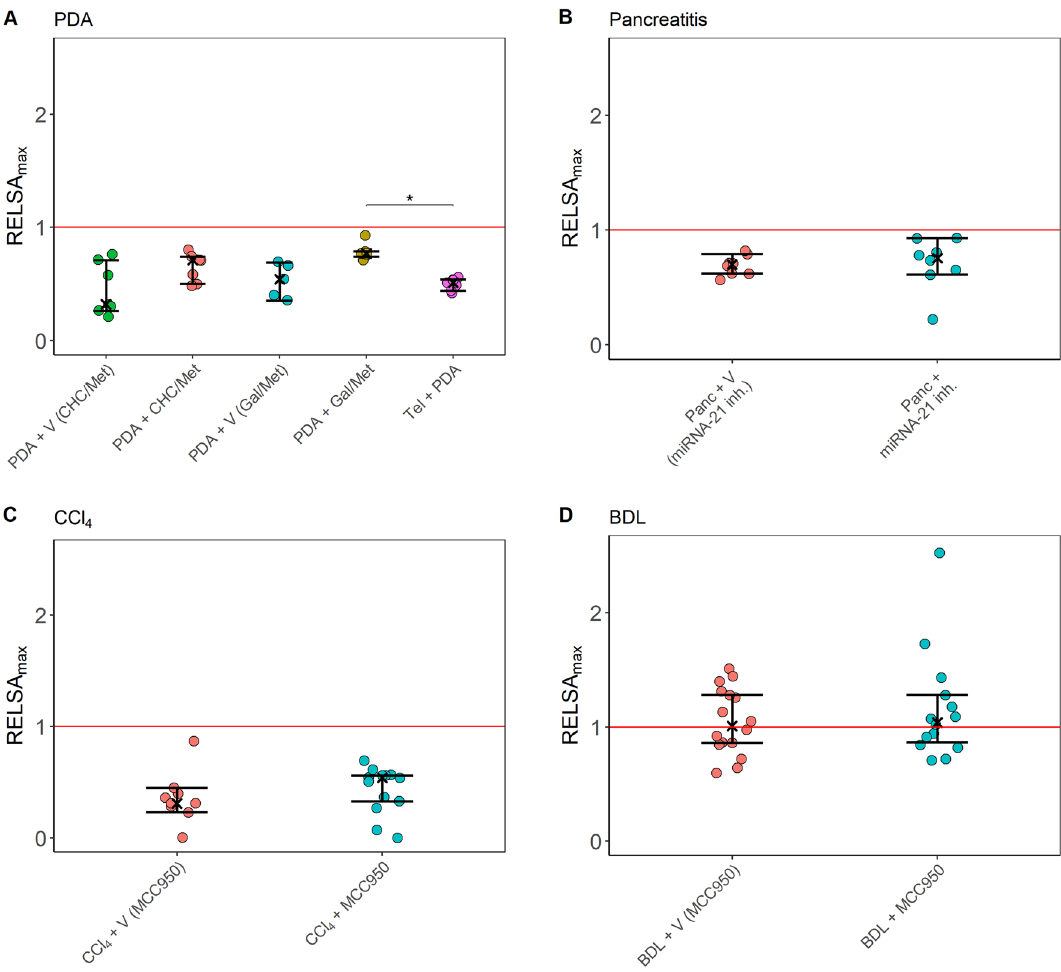
Figure 5. Within-model comparisons of distress using the variables body weight, burrowing activity, and the distress score, represented as the RELSA max metric. The red line denotes the maximally experienced severity in the telemetry experiment of laboratory A (reference line), also on the RELSA scale. In each animal model, the distress was assessed between treatment groups. The panels show PDA ( A ), pancreatitis ( B ), carbon tetrachloride (CCl 4 ) ( C ), and the cholestasis (BDL) model ( D )—always in comparison to the reference level. Distinct treatments with drugs (CHC/Met, Gal/Met, miRNA-21 inh., MCC950) or treatment with appropriate vehicle controls (V) are indicated. The 95% confidence intervals in all treatment groups remain below the reference line, indicating no evidence that any analyzed treatment has a higher severity than the surgery model. The Kruskal–Wallis test revealed a significant difference between the treatment groups only in panel ( A ) ( χ 2 = 16.12, df = 4, p-value = 0.003), more specifically between PDA + Gal/Met and Tel + PDA (*p adj = 0.021). The graphs depict the RELSA max values obtained from individual RELSA analyses, the bootstrapped median estimators, and the 95% confidence intervals. ( A ) PDA + V (CHC/Met) n = 7, PDA + CHC/Met n = 7, PDA + V (Gal/Met) n = 5, PDA + Gal/Met n = 7, Tel + PDA n = 7; ( B ) Panc + CR (miRNA-21 inh.) n = 8, Panc + miRNA-21 inh. n = 8; ( C )